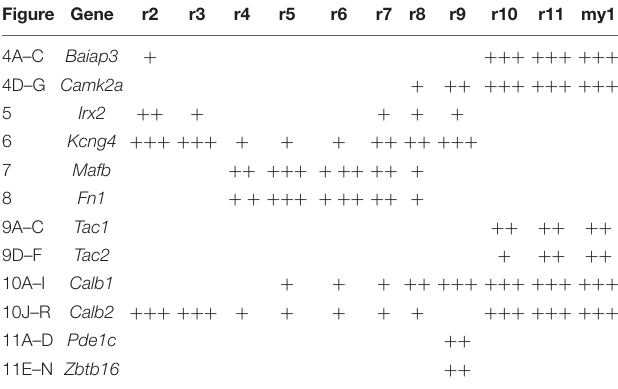
TABLE 1 | Summary of the expression of each gene in the rhombomeric portions of the trigeminal column. Figure